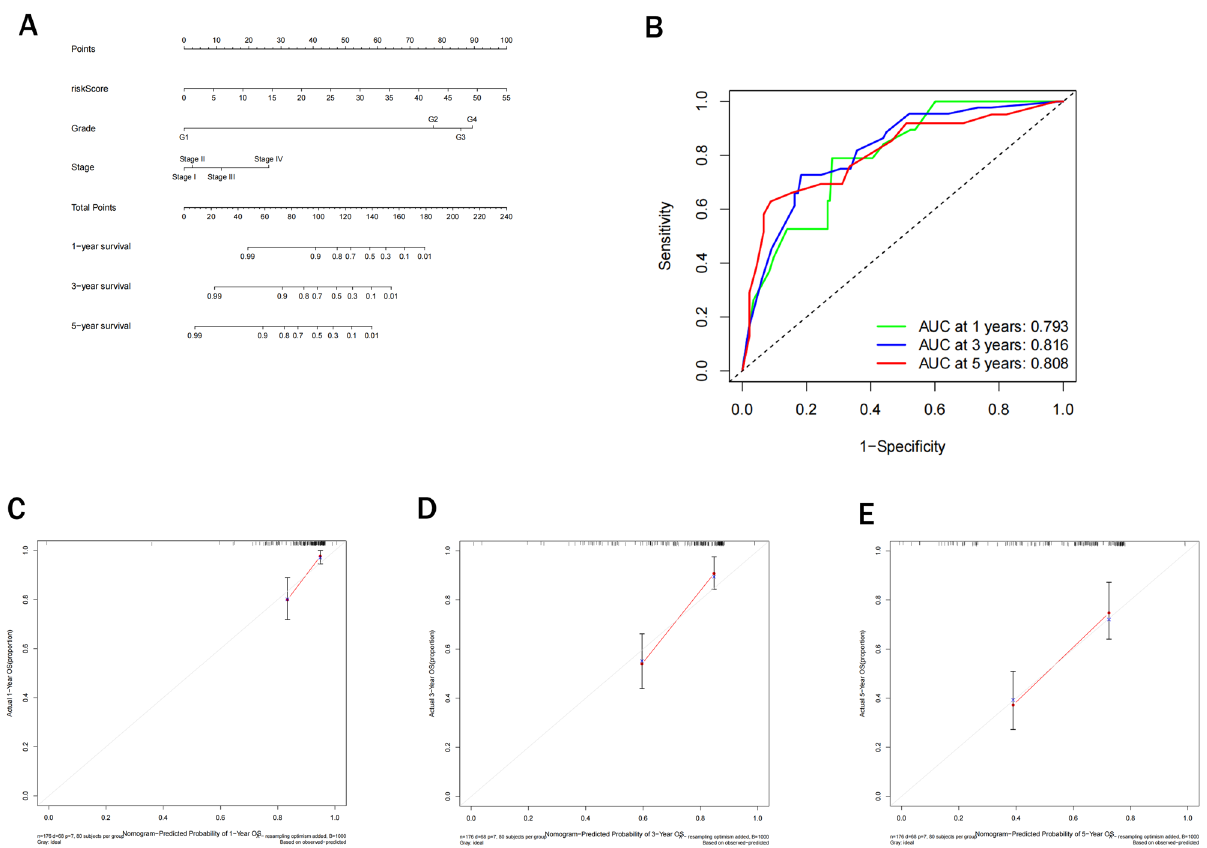
( C–E ) 1-, 3-, and 5-year survival calibration curves of the